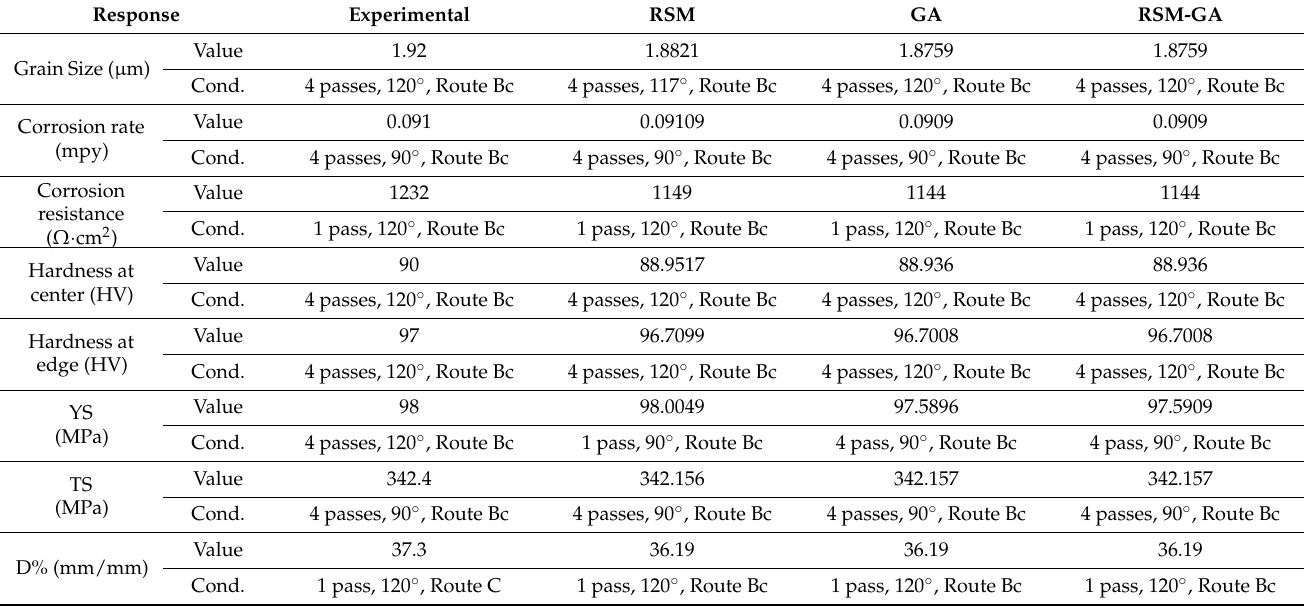
Table 4. Summary of the results of the ECAP process.